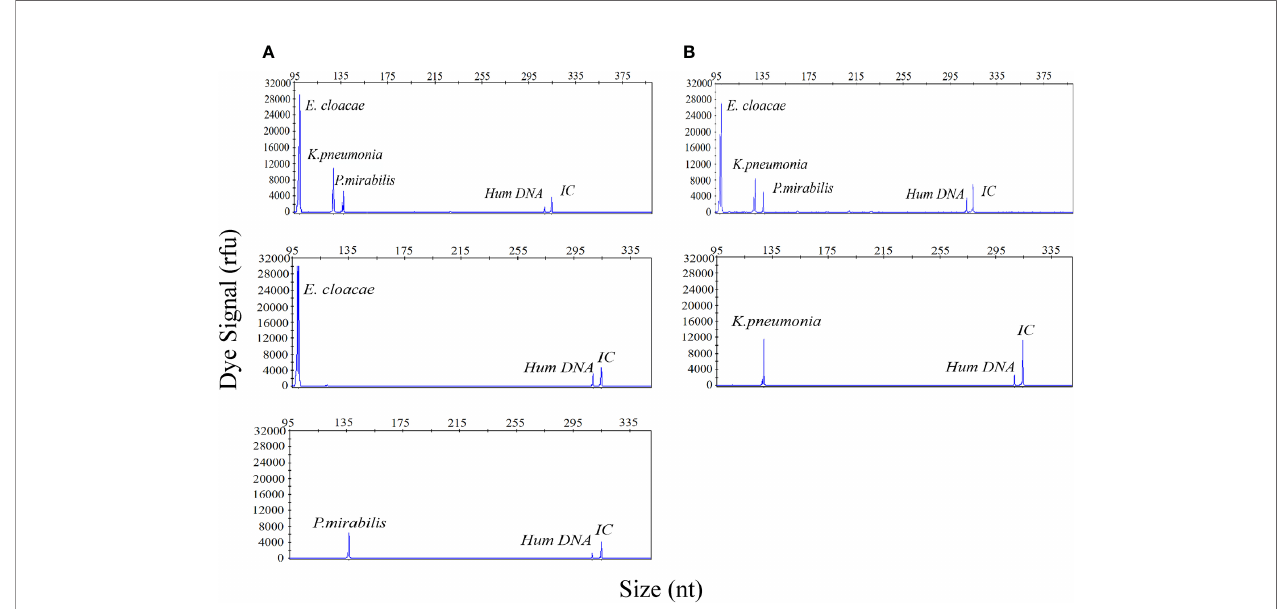
FIGURE 3 | The UTI-HMGS assay accurately detected individual uropathogen in a polymicrobial mixture without interference from other target genes. (A) E. cloacae , K. pneumoniae , and P. mirabilis plasmids were combined in different proportions (1×10 3 copies/µL, 1×10 2 copies/µL, and 10 copies/µL, respectively); these produced speci fi c peaks at 100 bp, 129 bp, and 138 bp, with high, mid-range and low signal intensities (30,000 rfu, 120,00 rfu, and 6,000 rfu, respectively). (B) The combined plasmids of three uropathogens and 5 negative control pathogen templates consistently showed speci fi c peaks for E. cloacae , K. pneumoniae and P. mirabilis with no interference. When tested individually, E. cloacae (C) , K. pneumoniae (D) and P. mirabilis (E) produced speci fi c peaks at 100 bp, 129 bp, and 138 bp, respectively, with corresponding intensities of 30,000, 12,000, and 6,000 rfu. The signals arising from Hum DNA and IC generated peaks at 308 bp and 315 bp, respectively, in each UTI-HMGS